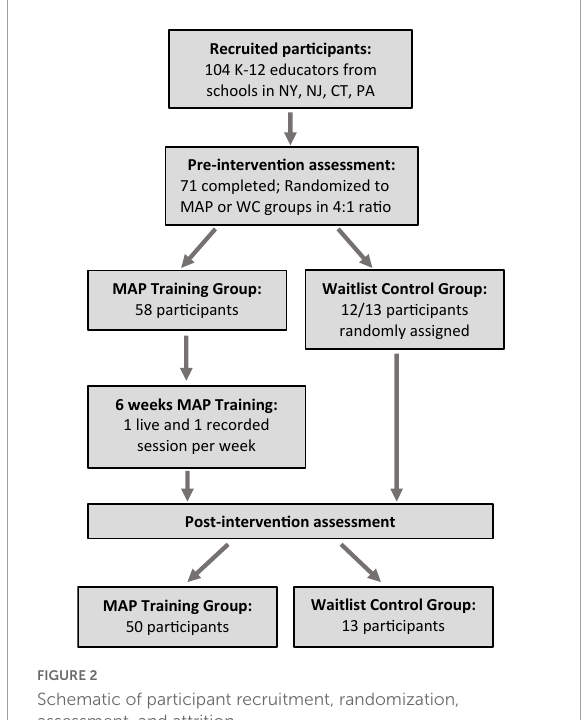
FIGURE2 Schematic of participant recruitment, randomization, assessment, and